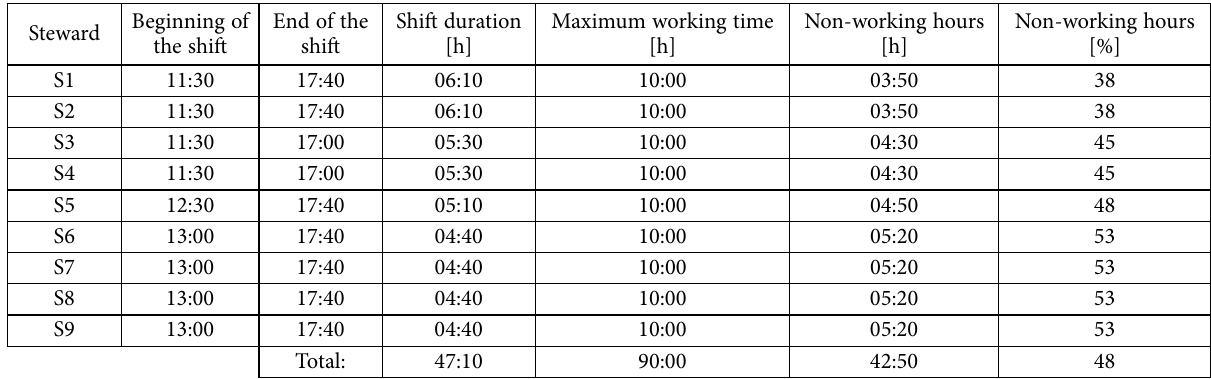
Table 6. Numerical results for instance of 3 flights